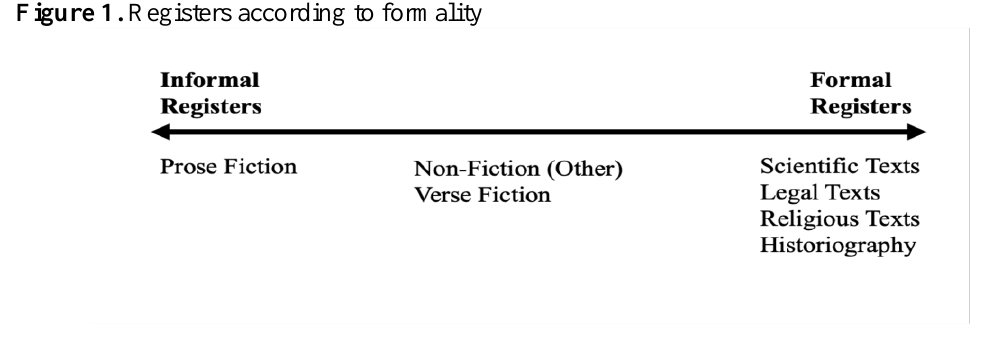
Figure 1. Registers according to